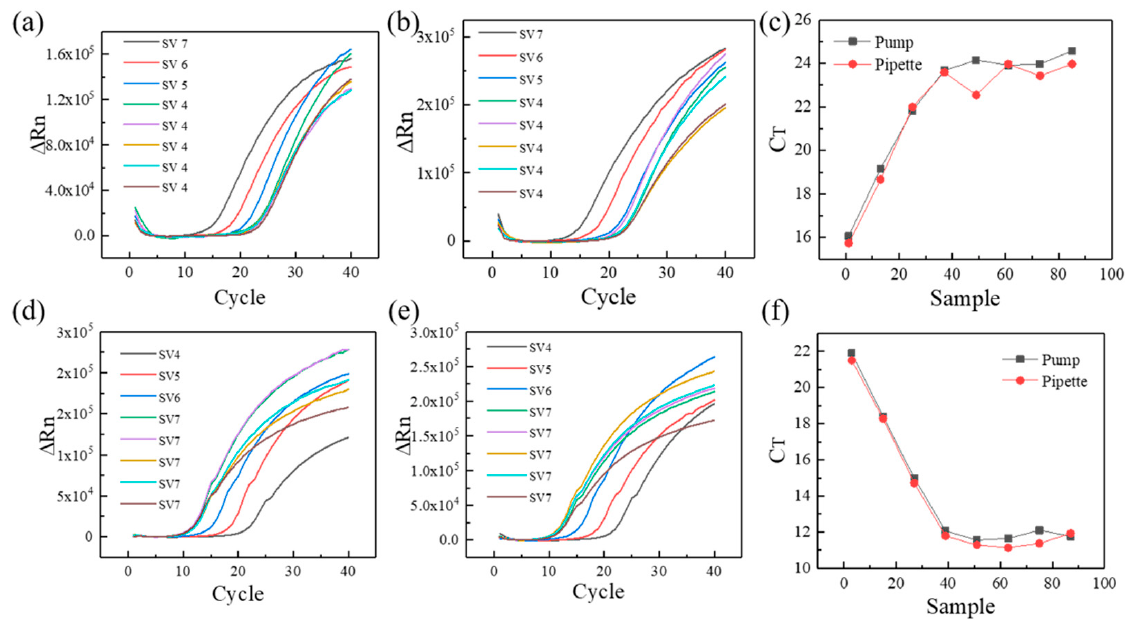
Figure 4. The qPCR results of different template DNA concentration: ( a ) relative fluorescence intensity of the custom-made three-dimensional automatic pipette for ORF1ab, ( b ) relative fluorescence intensity of the manual pipette for ORF1ab, ( c ) initial template DNA concentration for ORF1ab, ( d ) relative fluorescence intensity of the custom-made three-dimensional automatic pipette for pGEM- 3Zf (+), ( e ) relative fluorescence intensity of the manual pipette for pGEM-3Zf (+), ( f ) initial template DNA concentration for pGEM-3Zf (+). The x -axis in ( c , f ) means different samples (SV 4, SV 5, SV 6, SV 7).